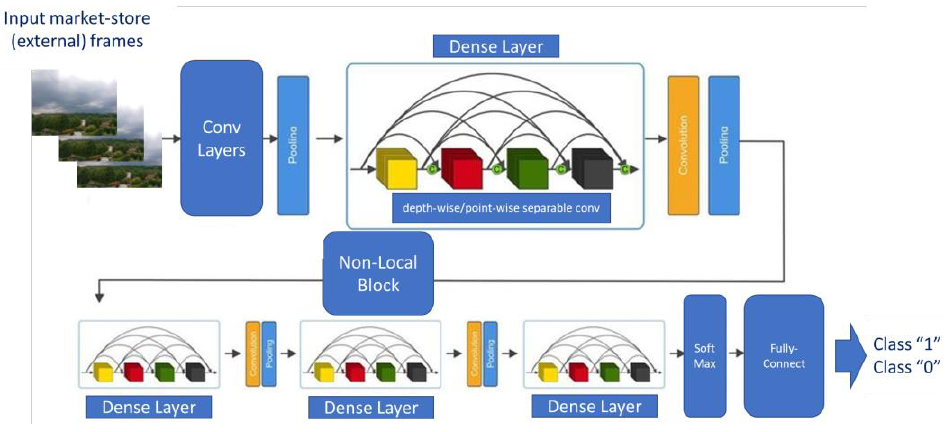
Figure 3. The proposed Climate Analysis System .